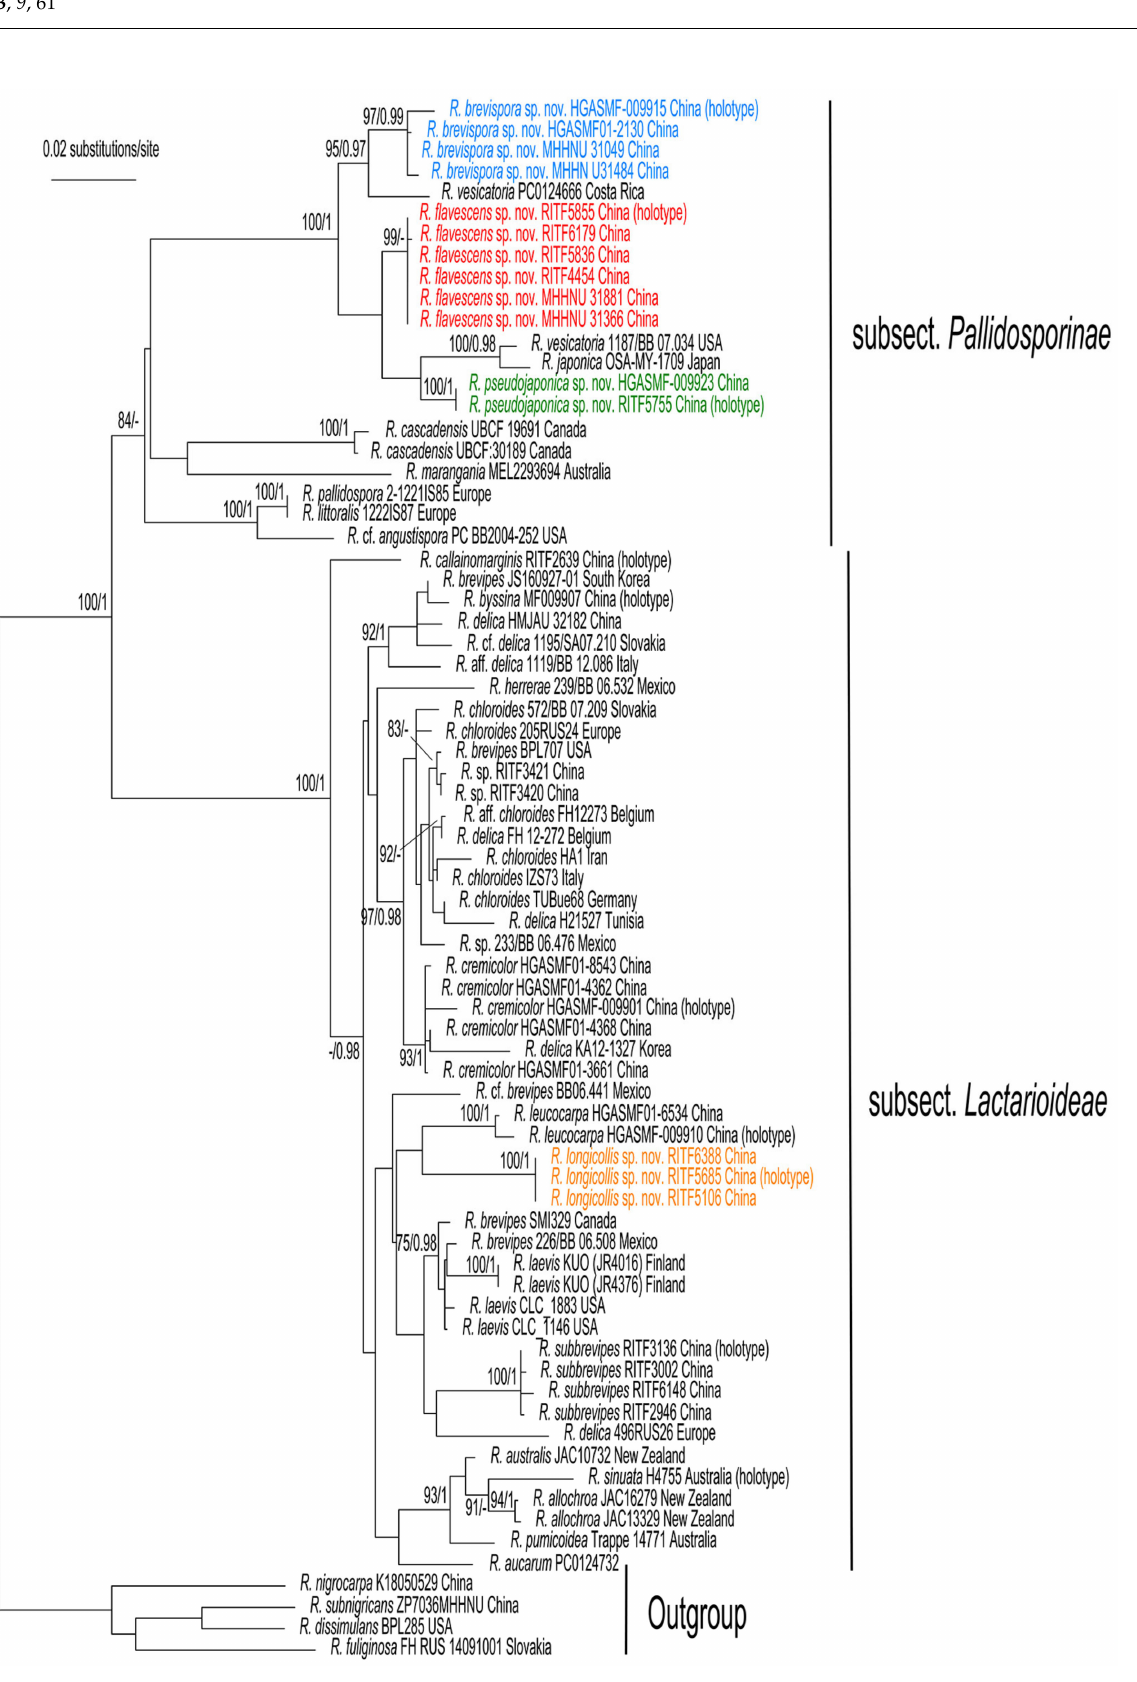
Figure 1. Phylogenetic tree of R. subg. Brevipedum based on the ITS-nrLSU- RPB2 -mtSSU dataset. Boot- strap support (BS) ≥ 75% and Bayesian posterior probabilities (PP) ≥ 0.95 are shown. Four species of R. subg. Compactae were selected as the outgroup. New species are marked with colored